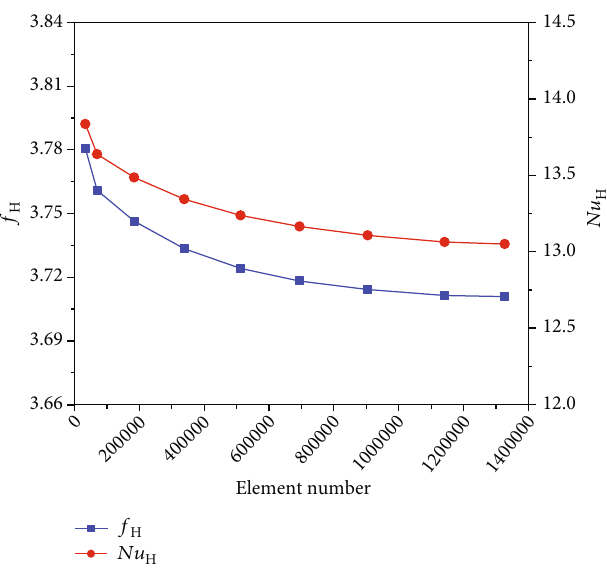
Figure 3: Mesh convergence study.